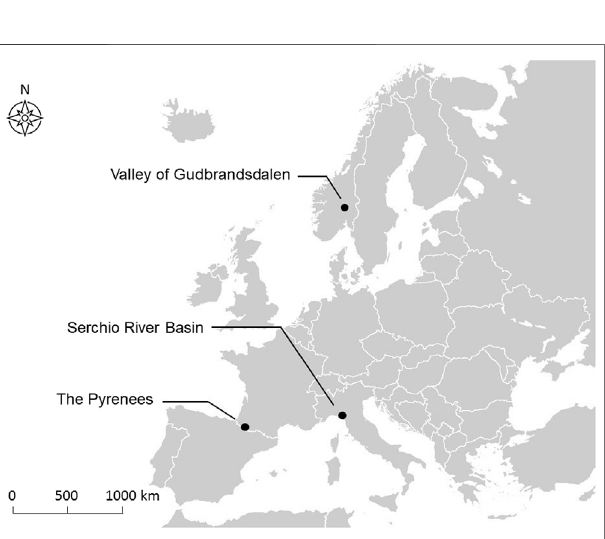
FIGURE 2 | Location of the different PHUSICOS concept case study